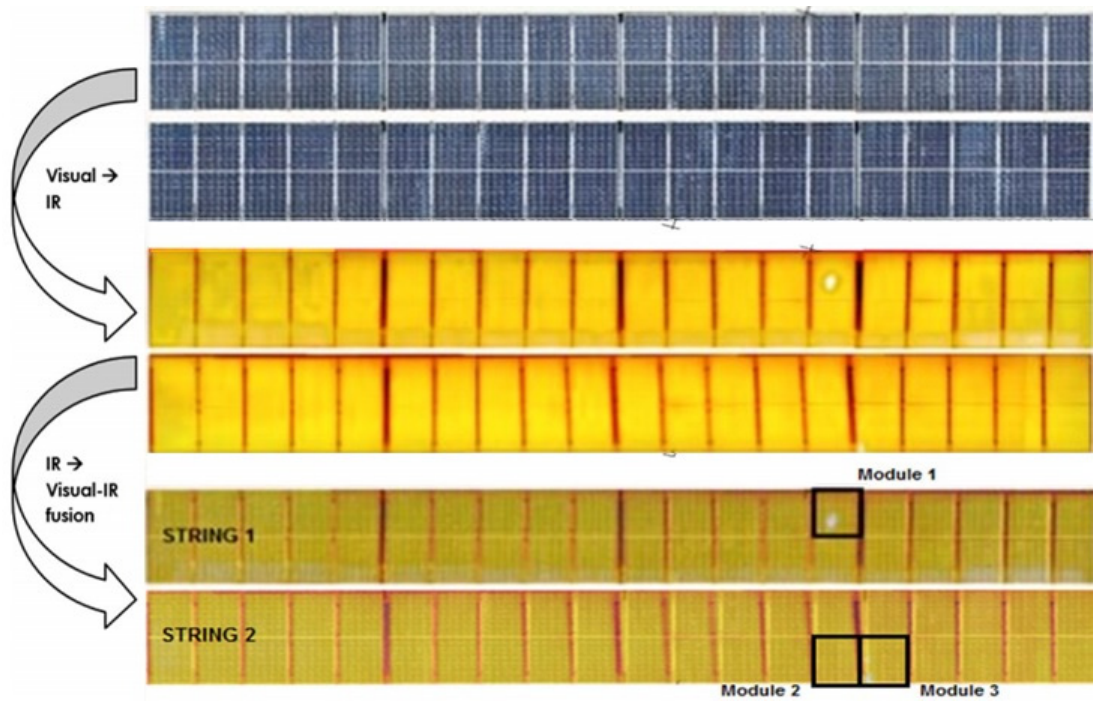
Figure 14. Implementation of a thermal orthophotoplan technique, for IRT mapping and fault detection in a PV plant [56].